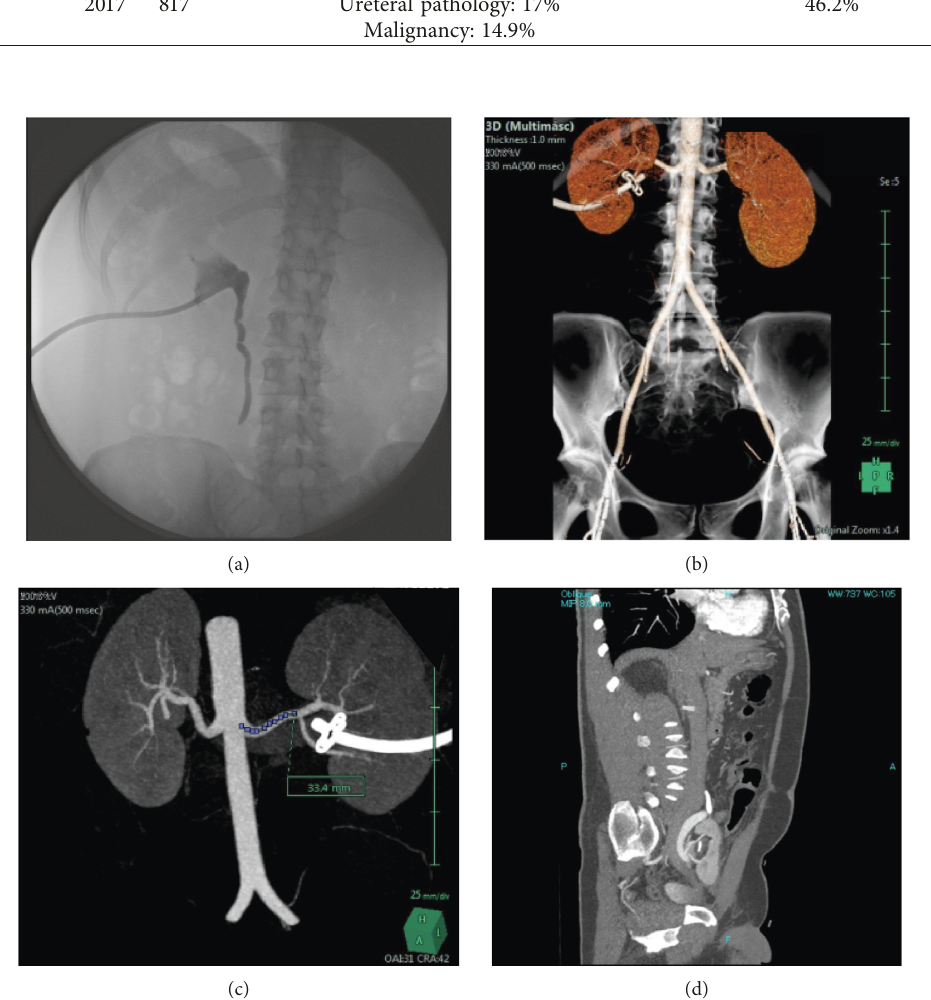
Figure 7: (a). Antegrade pyelography showing ureteral stop secondary to an iatrogenic ureteral lesion during open surgery. (b) and (c). Three-dimensional computed tomography reconstruction of the artery Ao, abdominal aorta. (d) Sagittal CT image showing KAT location and